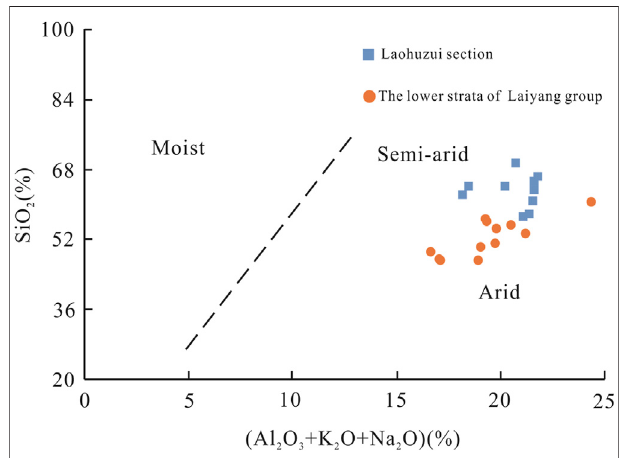
Frontiers in Earth Science |